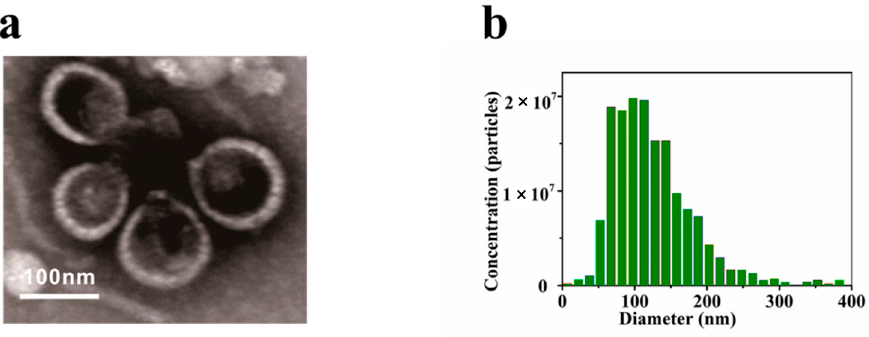
Figure 3. Characterization of exosomes: ( a ) TEM image of exosomes; ( b ) NTA analysis of exosomes.